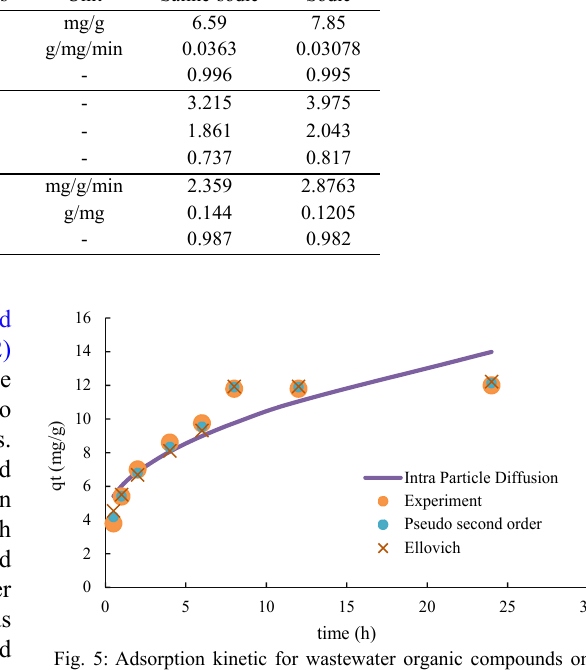
Table 4: Constants parameter of applied linear kinetic models for the adsorption wastewater organic compounds on soil Model